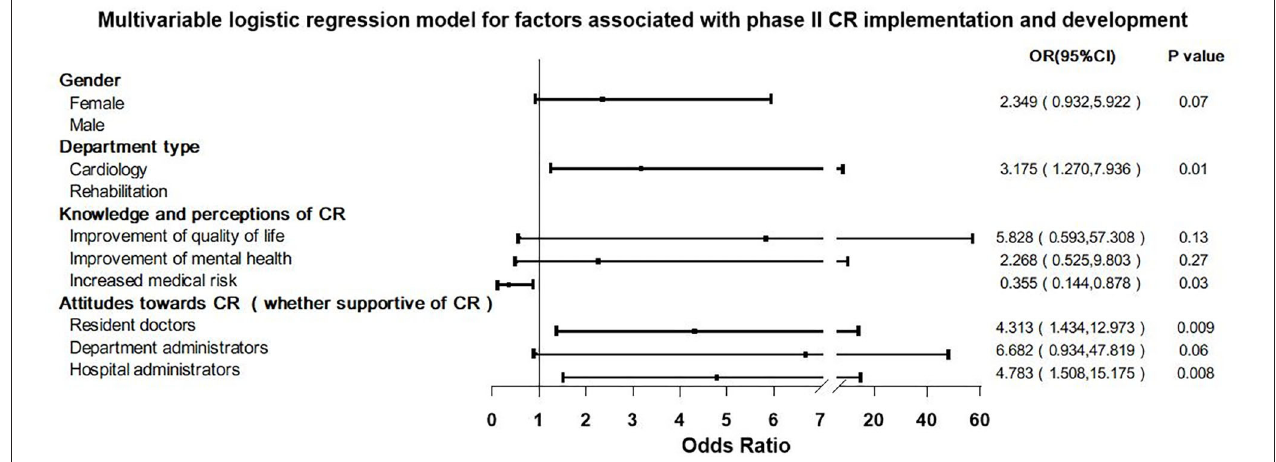
FIGURE 3 | Multivariable logistic regression model for factors associated with phase II cardiac rehabilitation (CR) implementation and development.